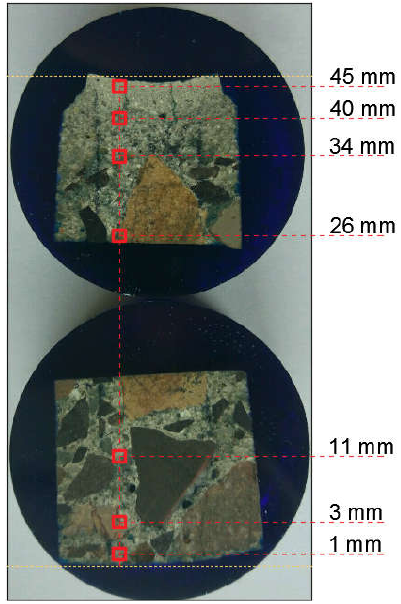
Figure 22. Arrangement of particular test grids—schematic representation.